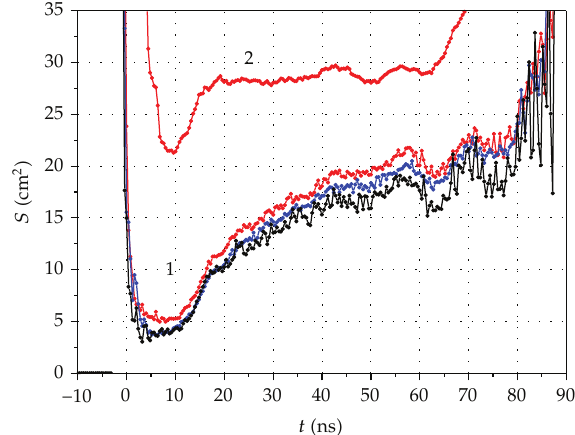
Figure 8: Change in cathode emitting surface during the generation of a pulse of current for a 60mm diameter cathode made of (cid:2) 1 (cid:3) graphite and (cid:2) 2 (cid:3) carbon fabric.